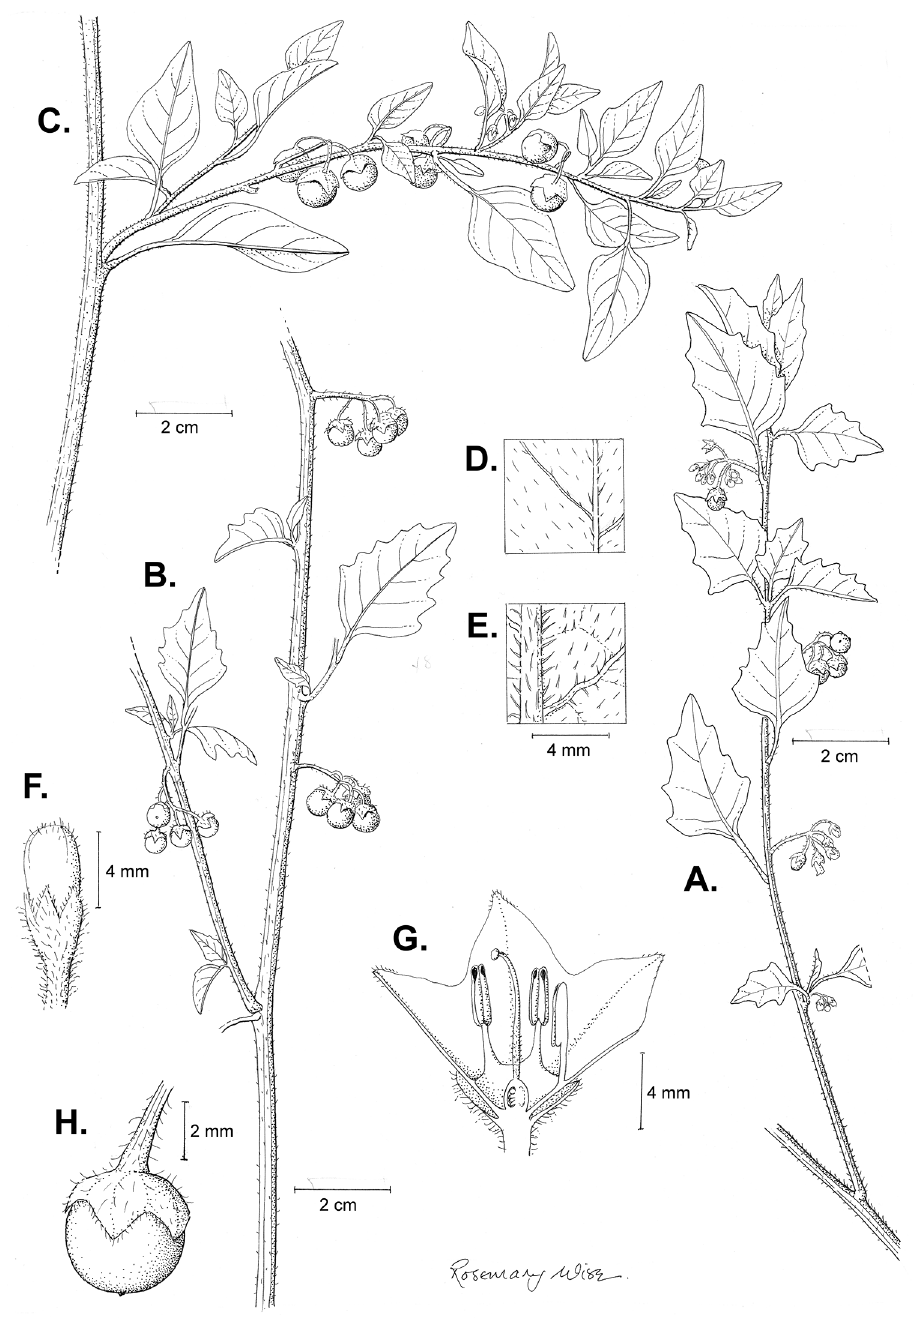
Figure 33. Solanum nitidibaccatum Bitter. A Habit B fruiting habit C fruiting habit showing leaf variation D detail of adaxial leaf surface E detail of abaxial leaf surface F bud G dissected flower H fruit ( A, C, F Henning 14 ; B, D–E, H Blake 186 ; C Arnow 740 ). Drawing by R. Wise (previously published in “PhytoKeys